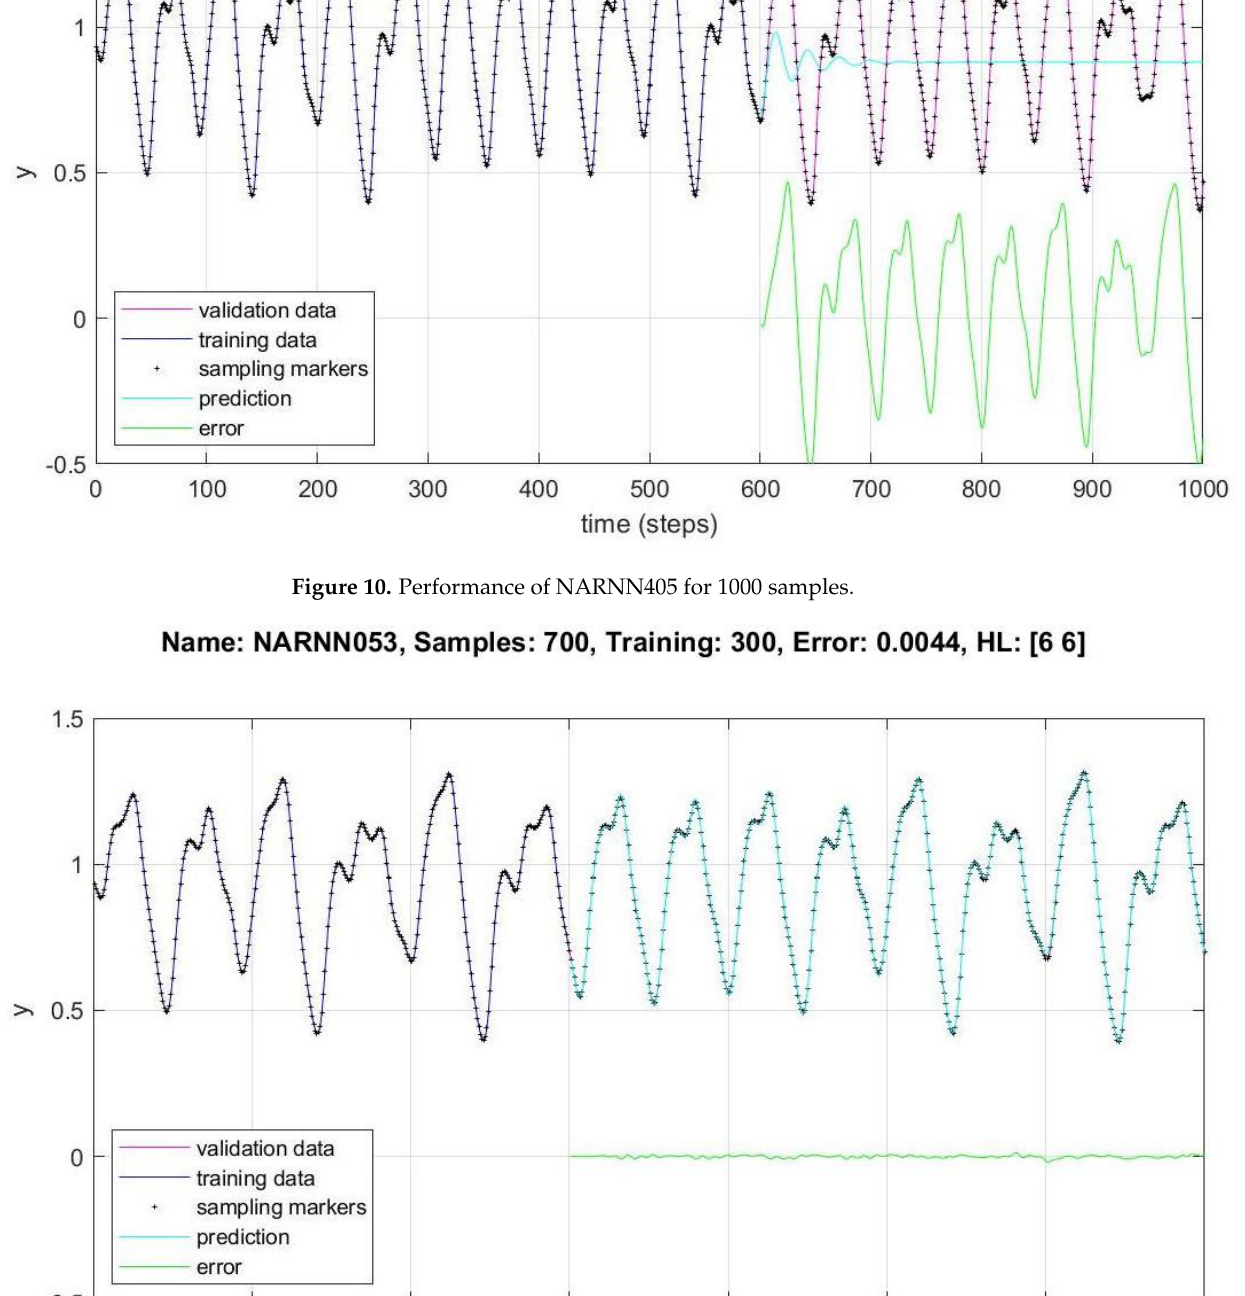
Table 3. Results of optimized experiments